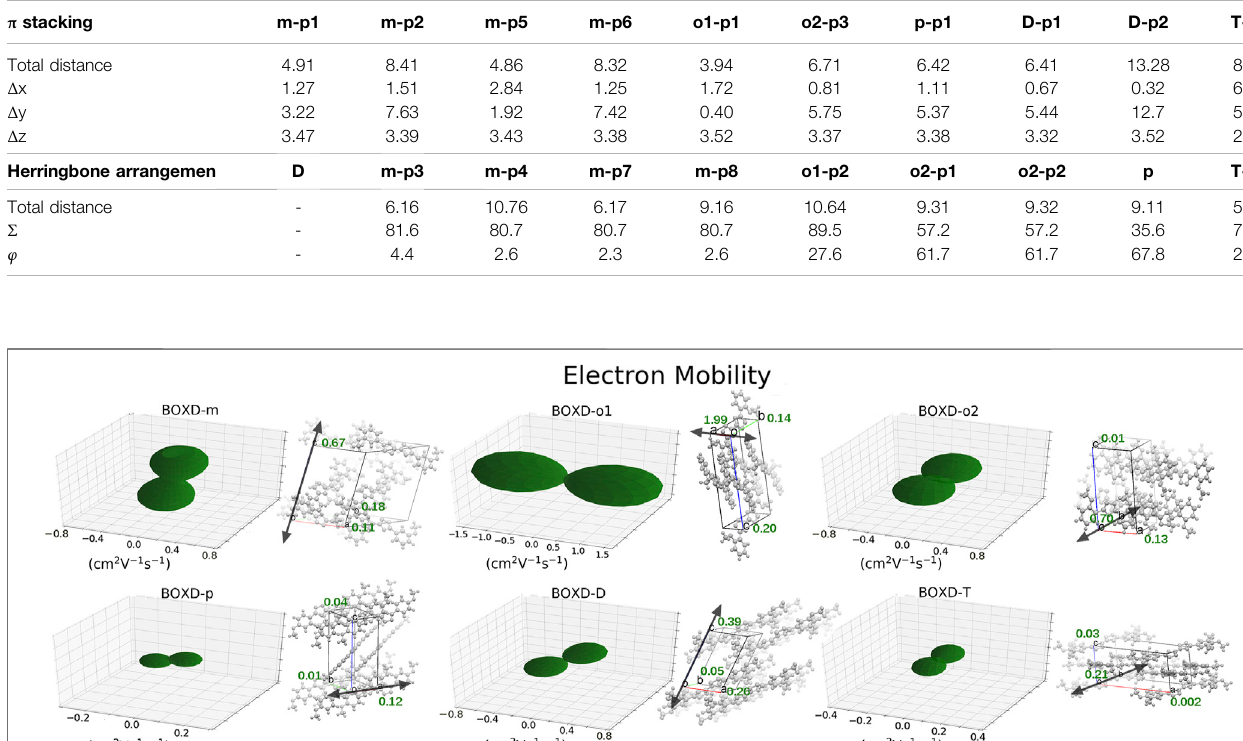
Frontiers in Chemistry |